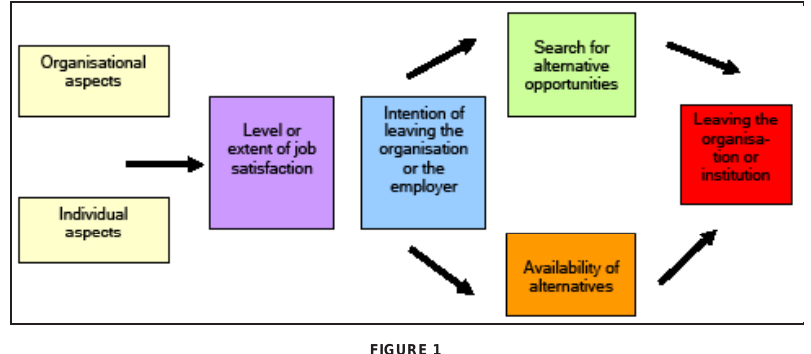
Figure 1 A model of labour turnover as a function of job satisfaction (Spector 1997, p.